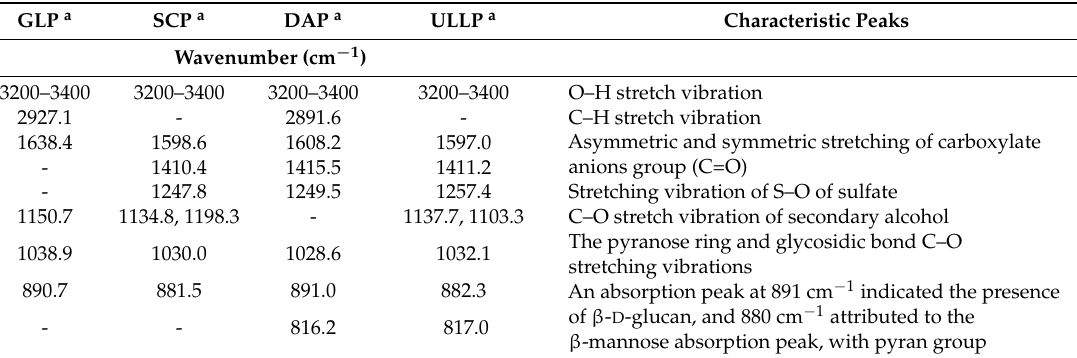
Figure 1. Fourier Transform Infrared Spectrometer (FT-IR) spectra of GLP ( a ); SCP ( b ); DAP ( c ) and ULLP ( d ). GLP, SCP, DAP, and ULLP are polysaccharides extracted from G. lemaneiformis , S. ceylonensis , D. Antarctica , and Ulva lactuca L., respectively. Table 3. The IR spectrum data of the four polysaccharides.